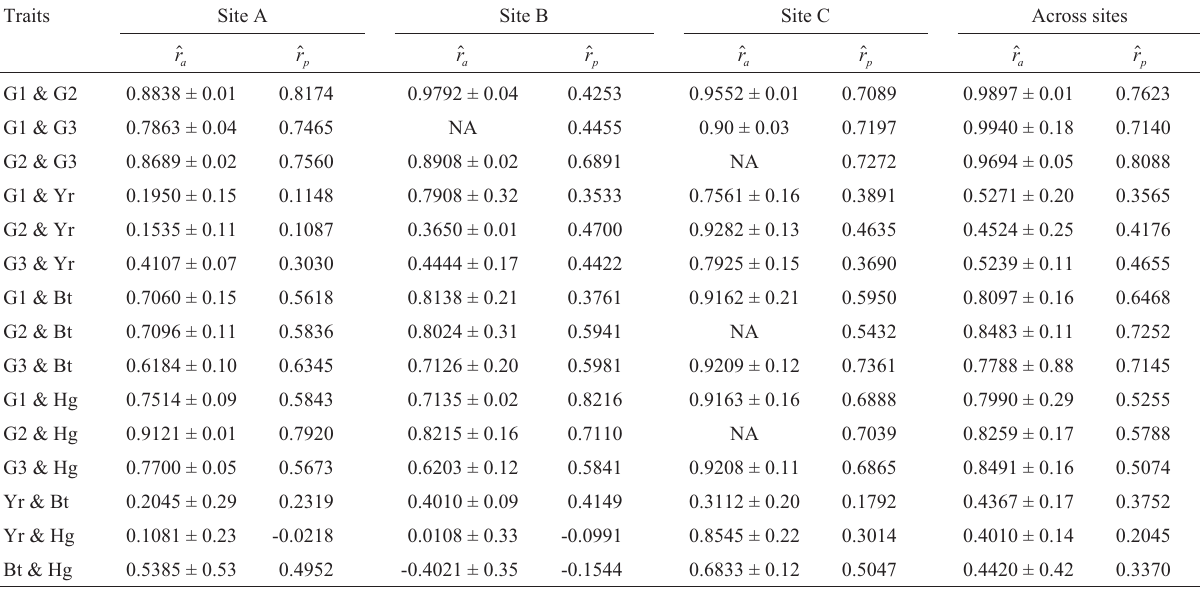
Table 6 - Site-related genetic ( (cid:1) r ) and phenotypic ( (cid:1) r ) correlations between traits (rubber yield (Yr), bark thickness (Bt) and height gain (Hg)) in 22 a p open-pollinated progenies of Hevea growing at three sites (Votuporanga (A), Pindorama (B) and Jaú (C)) in the Brazilian state of São Paulo. Girth measured when the trees were one (G1), two (G2) and three (G3) years old.